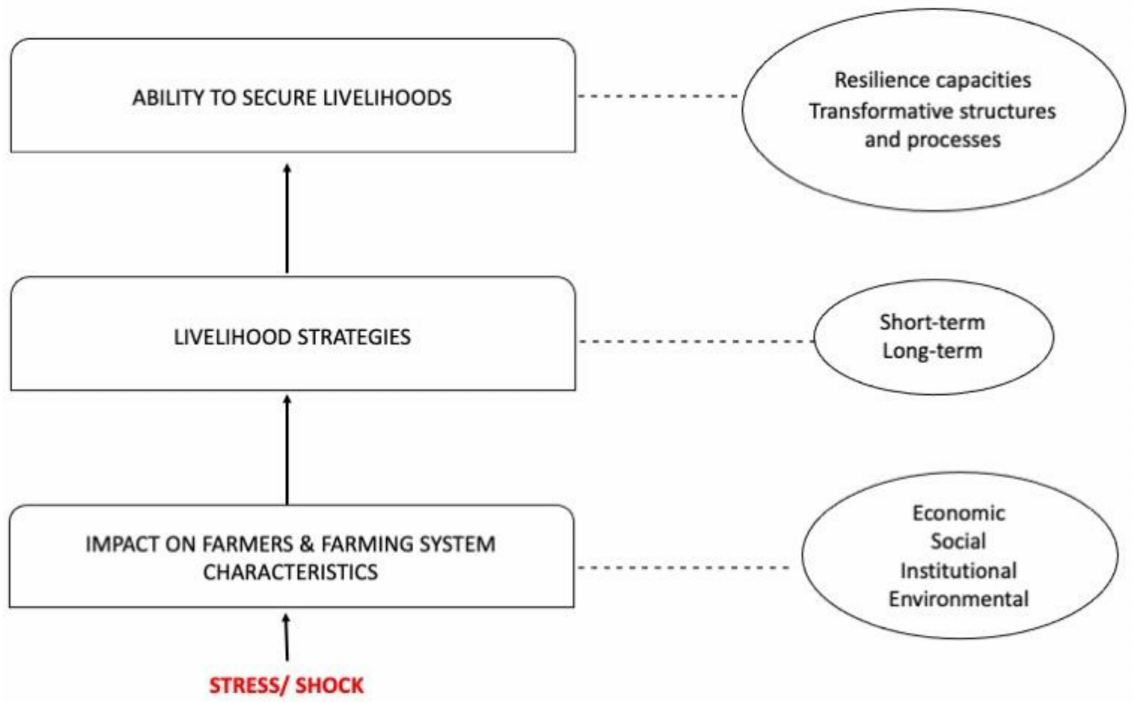
Figure 2. The framework used to study impacts, responses to shock, and ability to secure livelihoods (adapted from Levine 2014 and Meuwissen et al.,